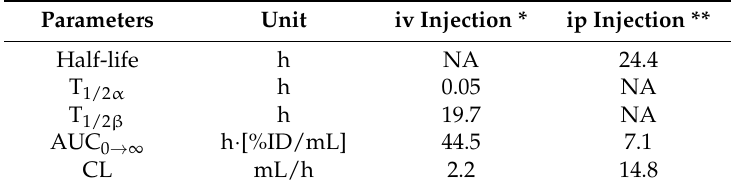
Table 2. The pharmacokinetic parameters of 111 In-Au@HSANPs after intravenous (iv) or intraperitoneal (ip) injection in CT-26 tumor/ascites mice.